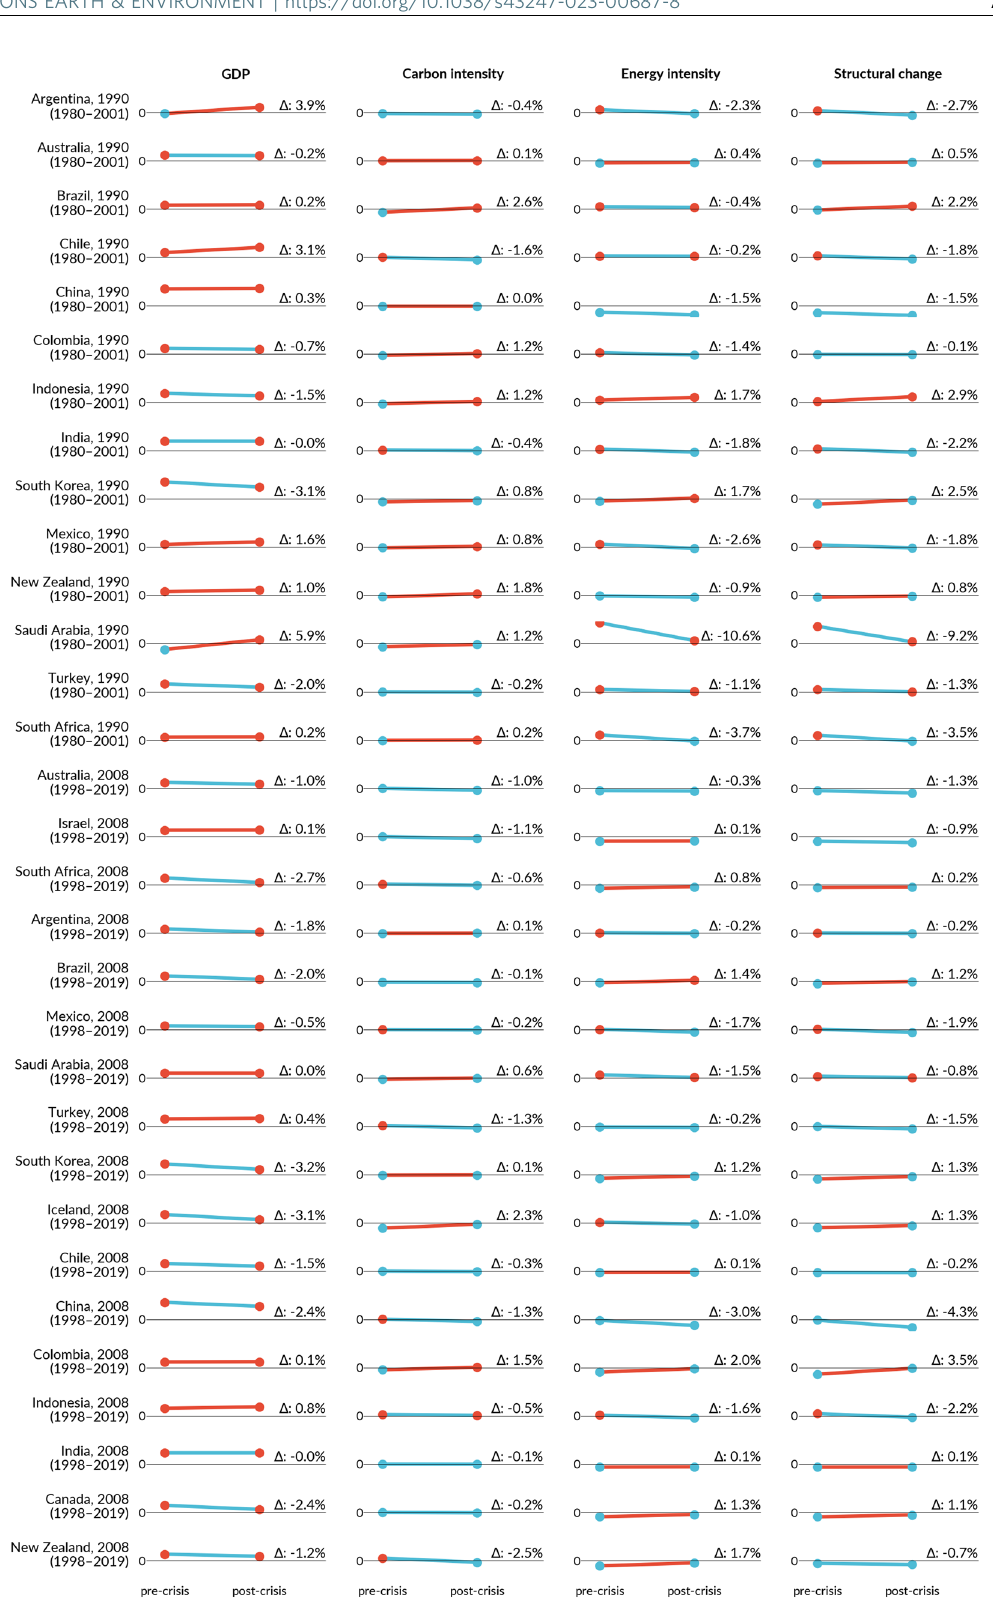
COMMUNICATIONS EARTH & ENVIRONMENT| (2023) 4:44